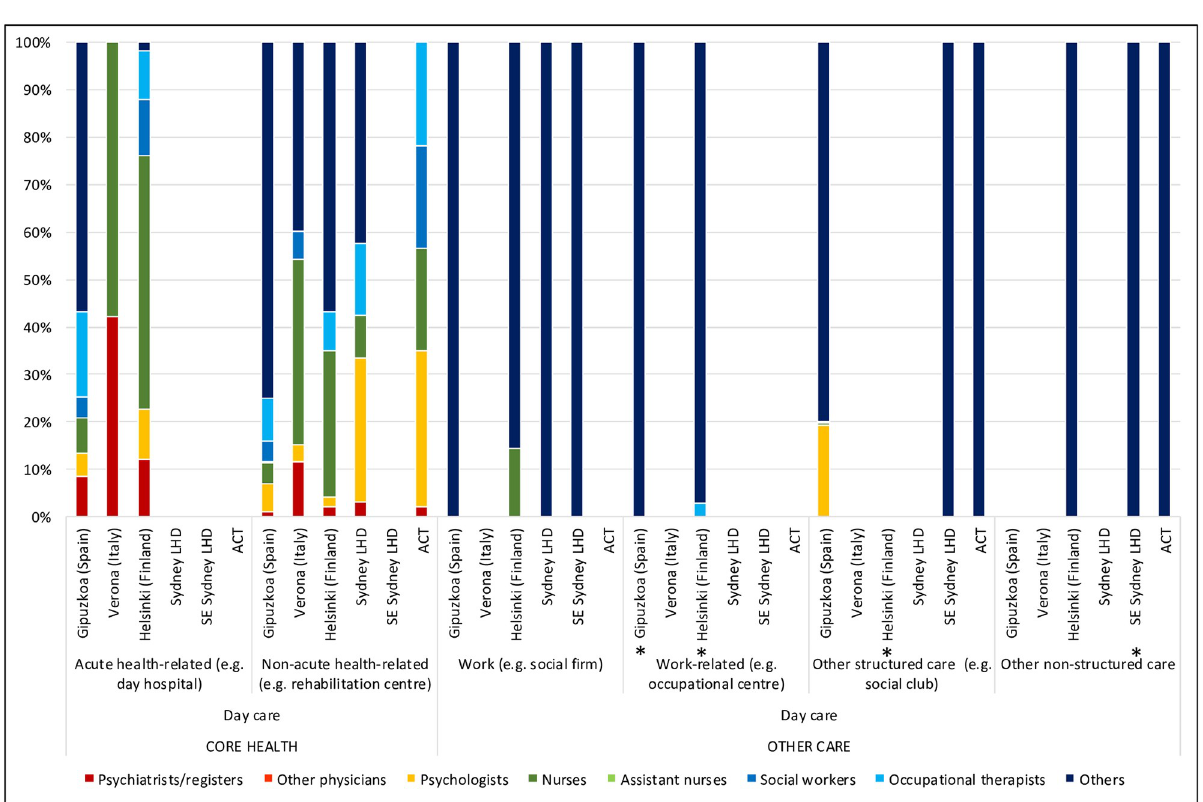
Fig 6. Percentage distribution of workforce in adult mental health services for day care in the six study areas. � Missing data.